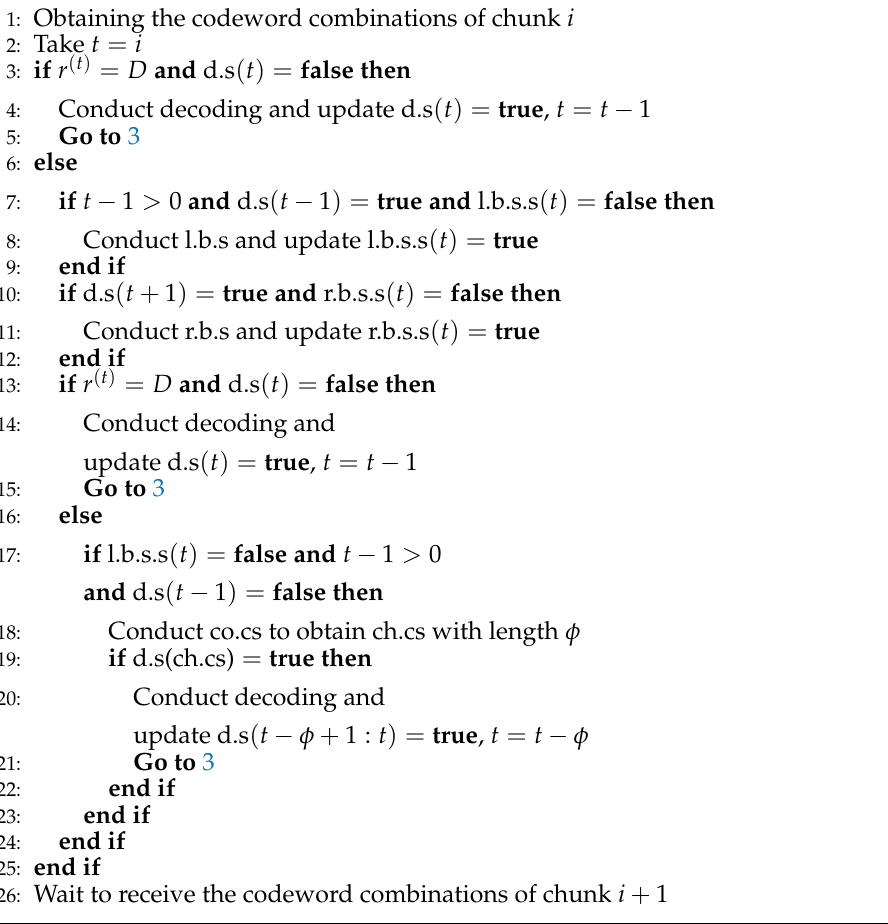
Algorithm 4 Decoding